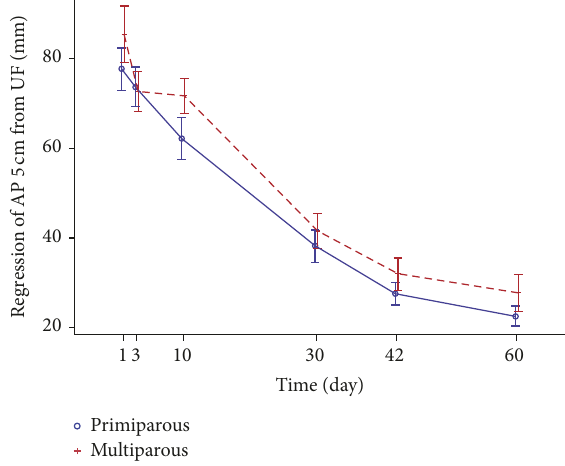
Figure 10: Regression of AP 5 cm below UF